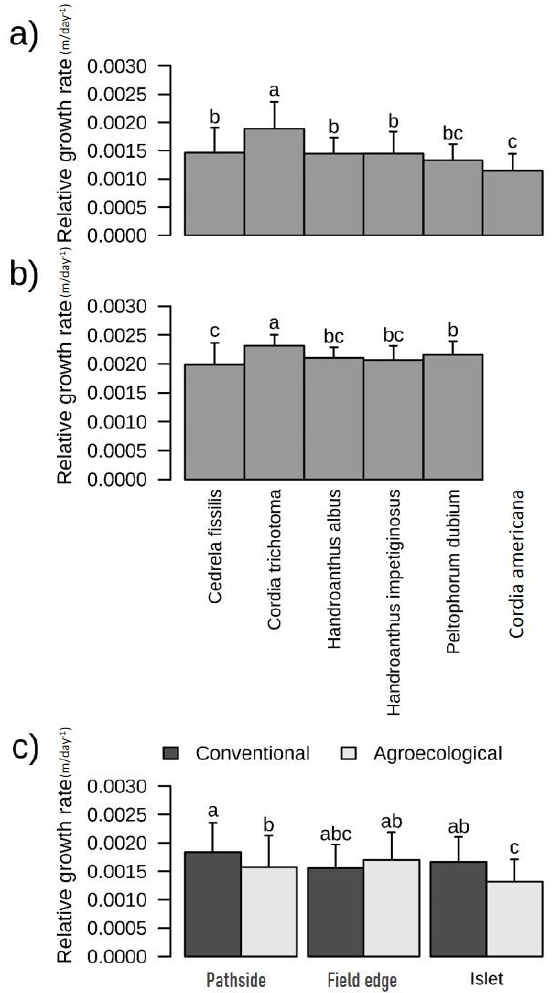
− 1 ) of native species planted in ( a ) Caaguaz ú and ( b ) Itap ú a. Figure 3. Relative growth rate (m day −1 ) of native species planted in ( a ) Caaguazú and ( b ) Itapúa. Figure 3. Relative growth rate (m day